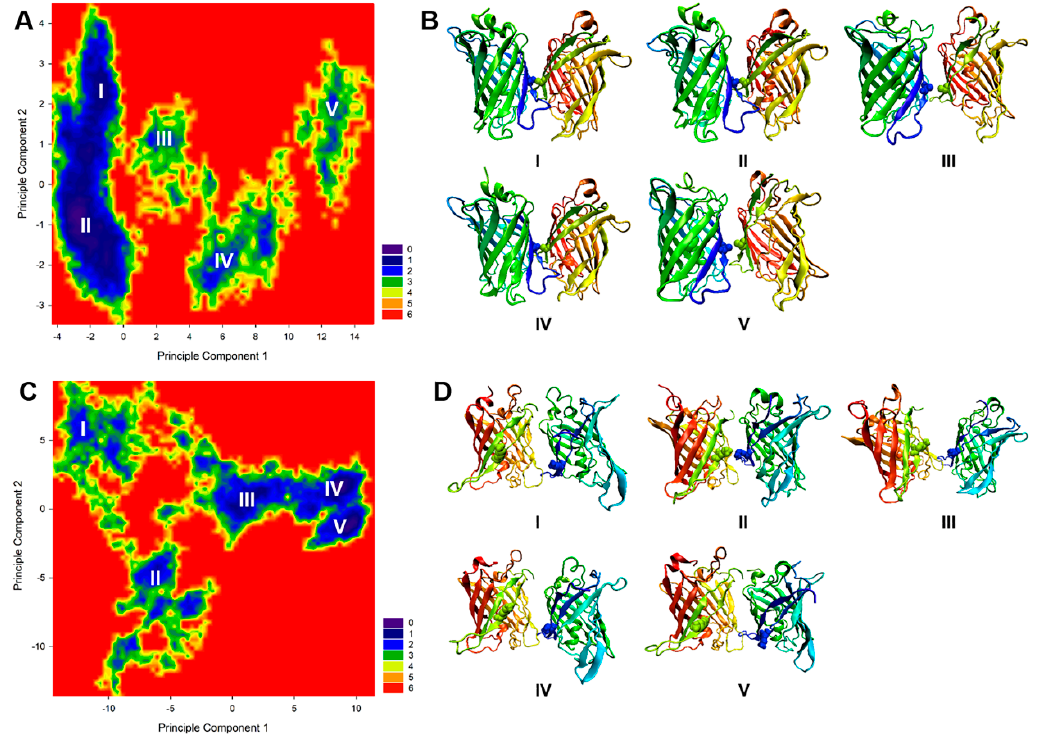
Figure 3. The folding population landscapes of GFP-206A and GFP-A206K projected onto the first two principle components. ( A ) Free energy landscape between the first and second principal components for GFP-206A. Regions of low free energy are indicated in cold colors (green to blue) and regions of high free energy in hot colors (orange to red). ( B ) Representative structures of the five highly-populated regions for GFP-206A. ( C ) Free energy landscape between the first and second principal components for GFP-A206K. ( D ) Representative structures of the five highly-populated regions for